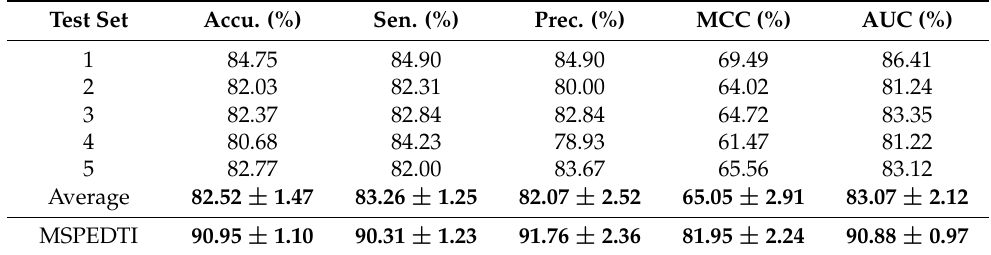
Table 6. Comparison results of the 2DPCA descriptor model and MSPEDTI on ion channel.